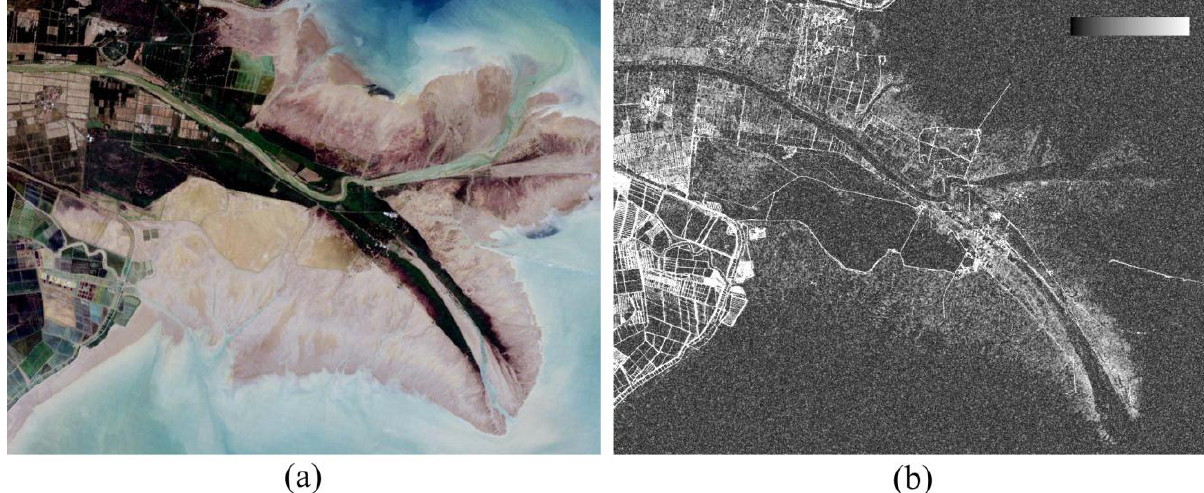
Fig. 4. (a) is Landsat TM image of Yellow River Delta, (b) is the coherence after the 4×20 pixels adaptive spatial filtering based on Anderson-Darling test